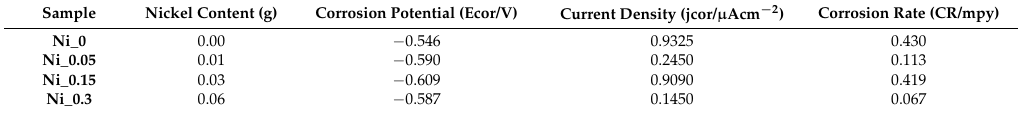
Table 5. The values of corrosion potential, current density and corrosion rate estimated for nickel-based samples.